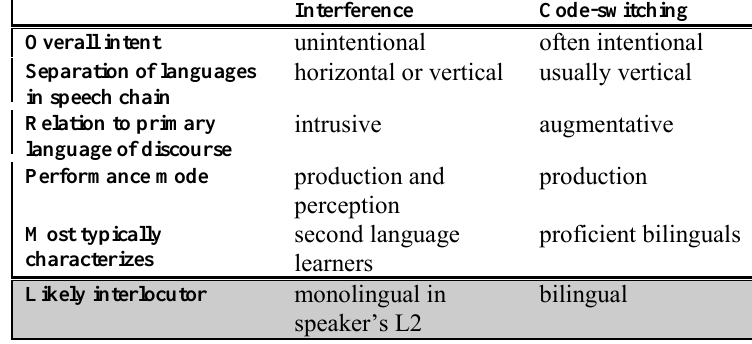
Table 2: From Eliasson (1995), with an added